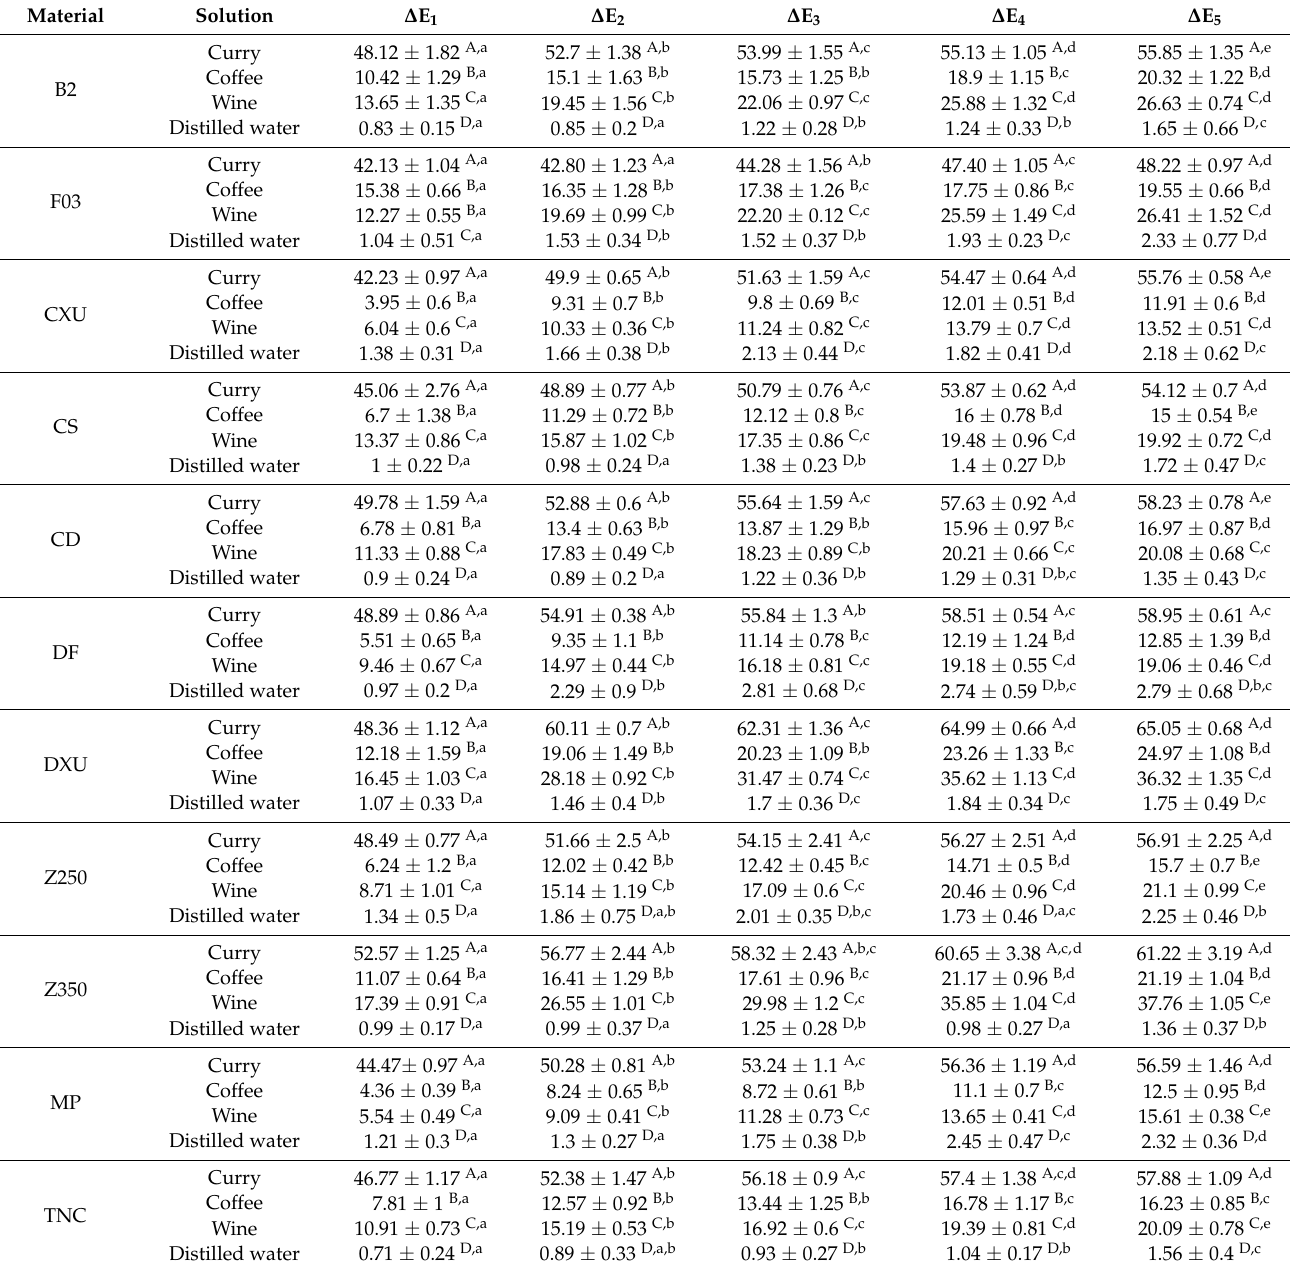
Table 2. Mean ∆ E values and standard deviations of 11 composite resins after 28 days of